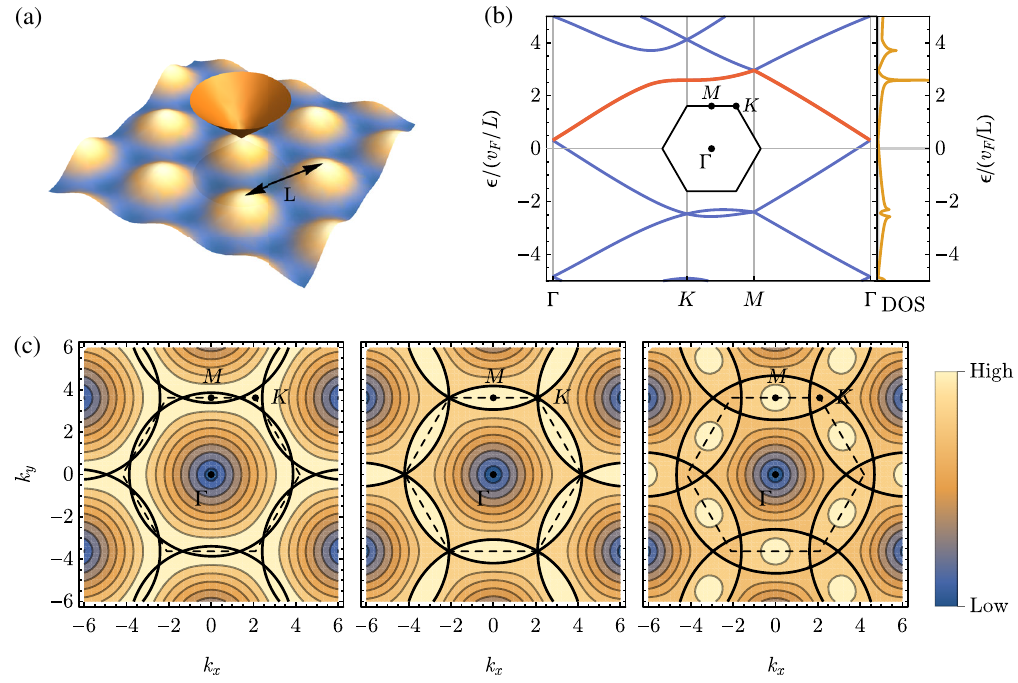
1 . 36 v =L . The c ¼ F